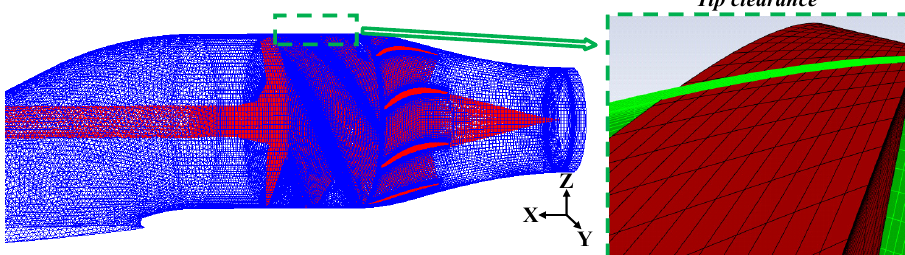
Figure 4. Computational grid system of the waterjet-propelled ship model.